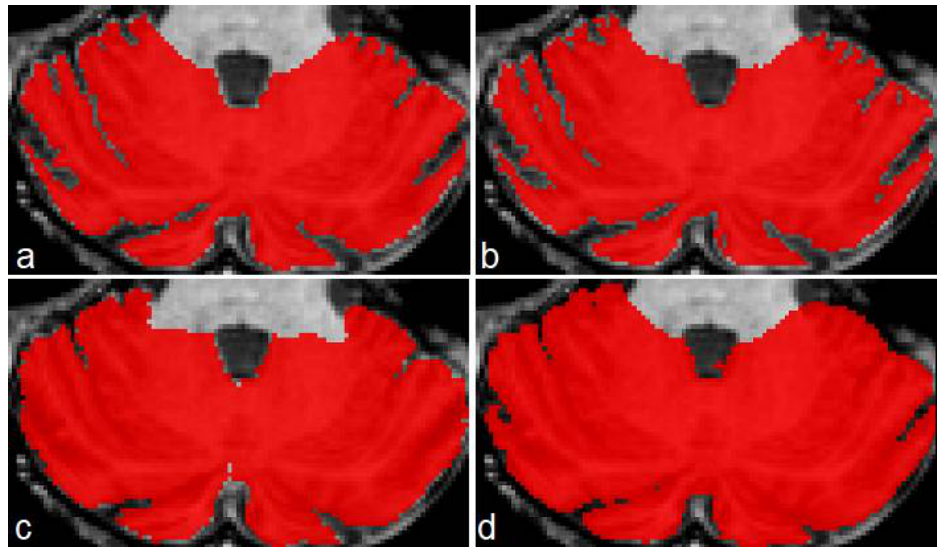
Figure 6. Segmentations produced by the three approaches for a sample image from the DLBS dataset. Original mask ( a ), followed by segmentation produced by M2 ( b ), CERES ( c ) and ACAPULCO ( d ).